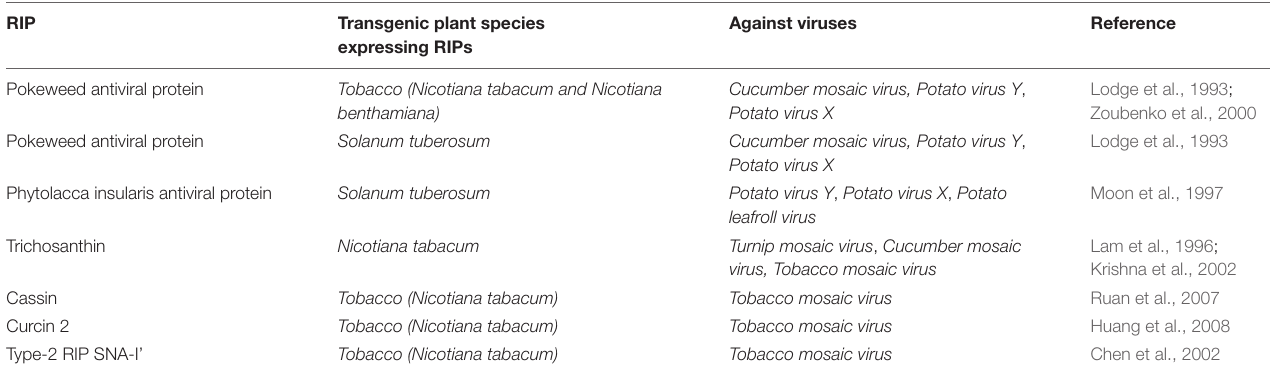
TABLE 5 | Transgenic plant species expressing RIPs show enhanced resistance to virus